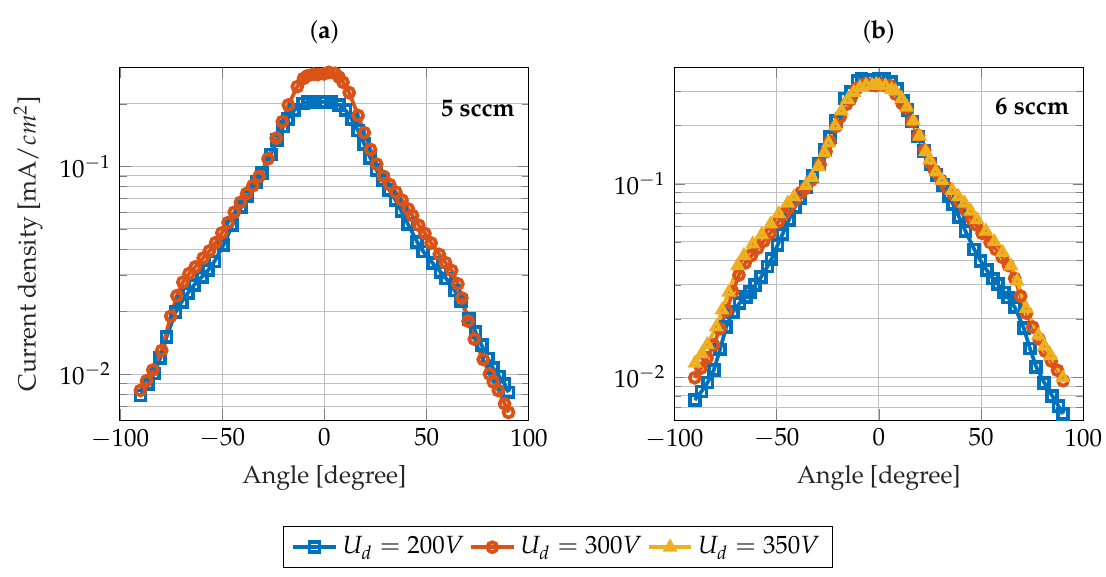
Figure 7. Semilog plot of j i angular distribution for different anode mass flows at ( a ) U d = 200 V and ( b ) U d = 300 V.